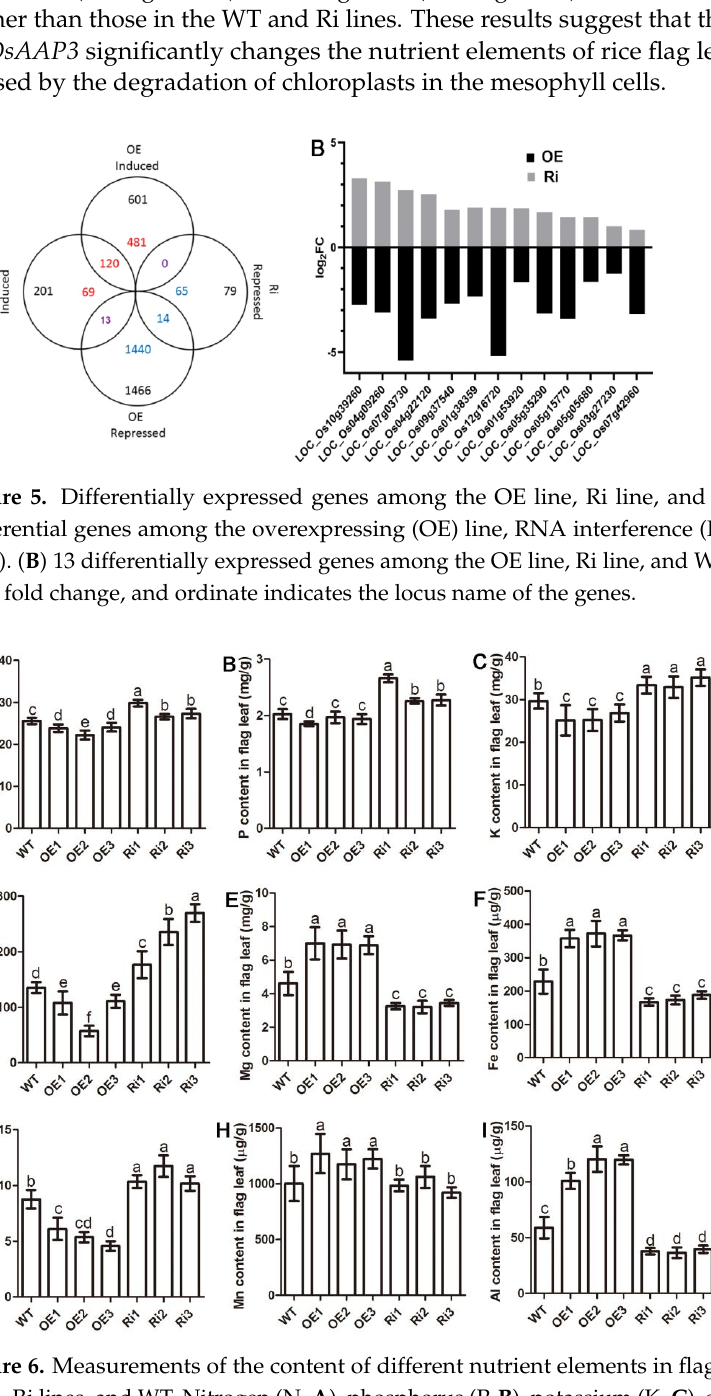
Figure 6. Measurements of the content of different nutrient elements in flag leaves among the OE lines, Ri lines, and WT. Nitrogen (N, A ), phosphorus (P, B ), potassium (K, C ), sodium (Na, D ), copper (Cu, E ), magnesium (Mg, F ), iron (Fe, G ), aluminum (Al, H ), and manganese (Mn, I ) contents among the overexpressing (OE) lines, RNA interference (Ri) lines, and wild-type (WT). The flag leaves was taken at 110 days after sowing. The letters above the error bars are ranked by the Duncan test at p < 0.05. Values are means ± standard deviation ( n = 5).